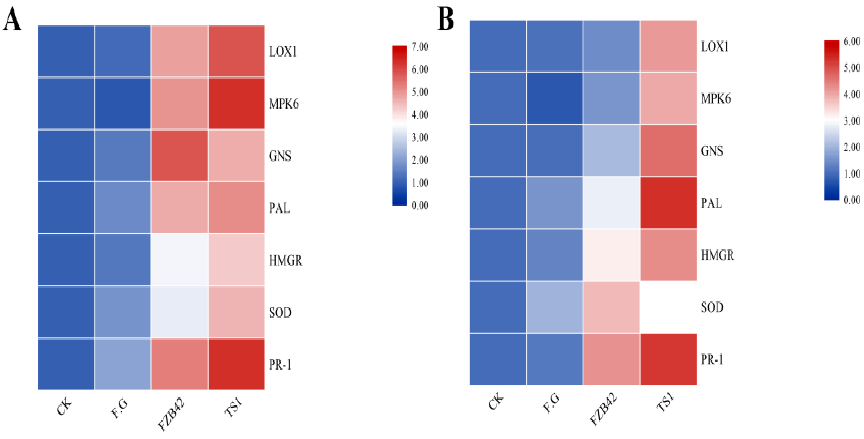
Figure 8. Quantification of defense enzymes activity: ( A ) polyphenol oxidase, ( B ) peroxidase, ( C ) phenylalanine ammonia- lyase, and ( D ) superoxide dismutase in wheat plants under different treatments at 15 and 25 °C. The error bars in the graphs represent the standard deviation (SD) from the means (n = 3). The statistical significance among different treat- ments was observed at p ≤ 0.05 by using Tukey’s HSD test.